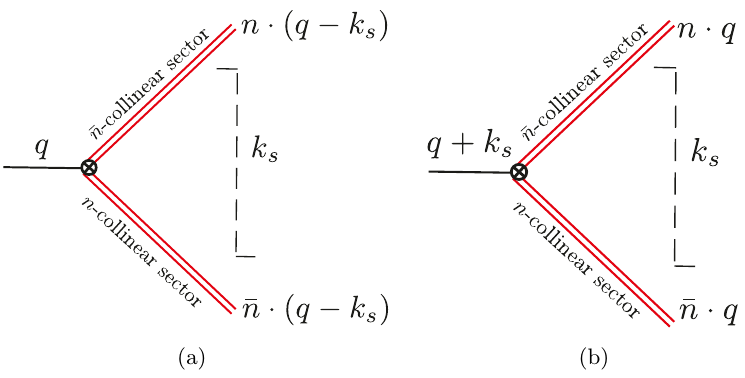
Figure 1 . Two di(cid:11)erent routings for the soft momentum. In a) the additional soft momentum is routed into the collinear sectors. In b) the additional momentum is routed in through the hard scattering vertex, simplifying the large momentum routed into the collinear